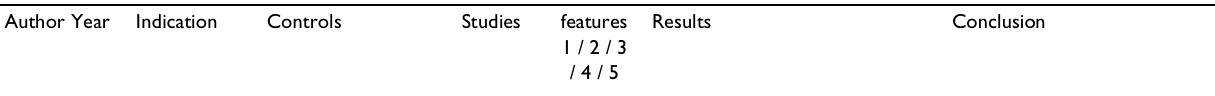
Table 1: Systematic reviews of clinical trials of acupuncture & acupressure in